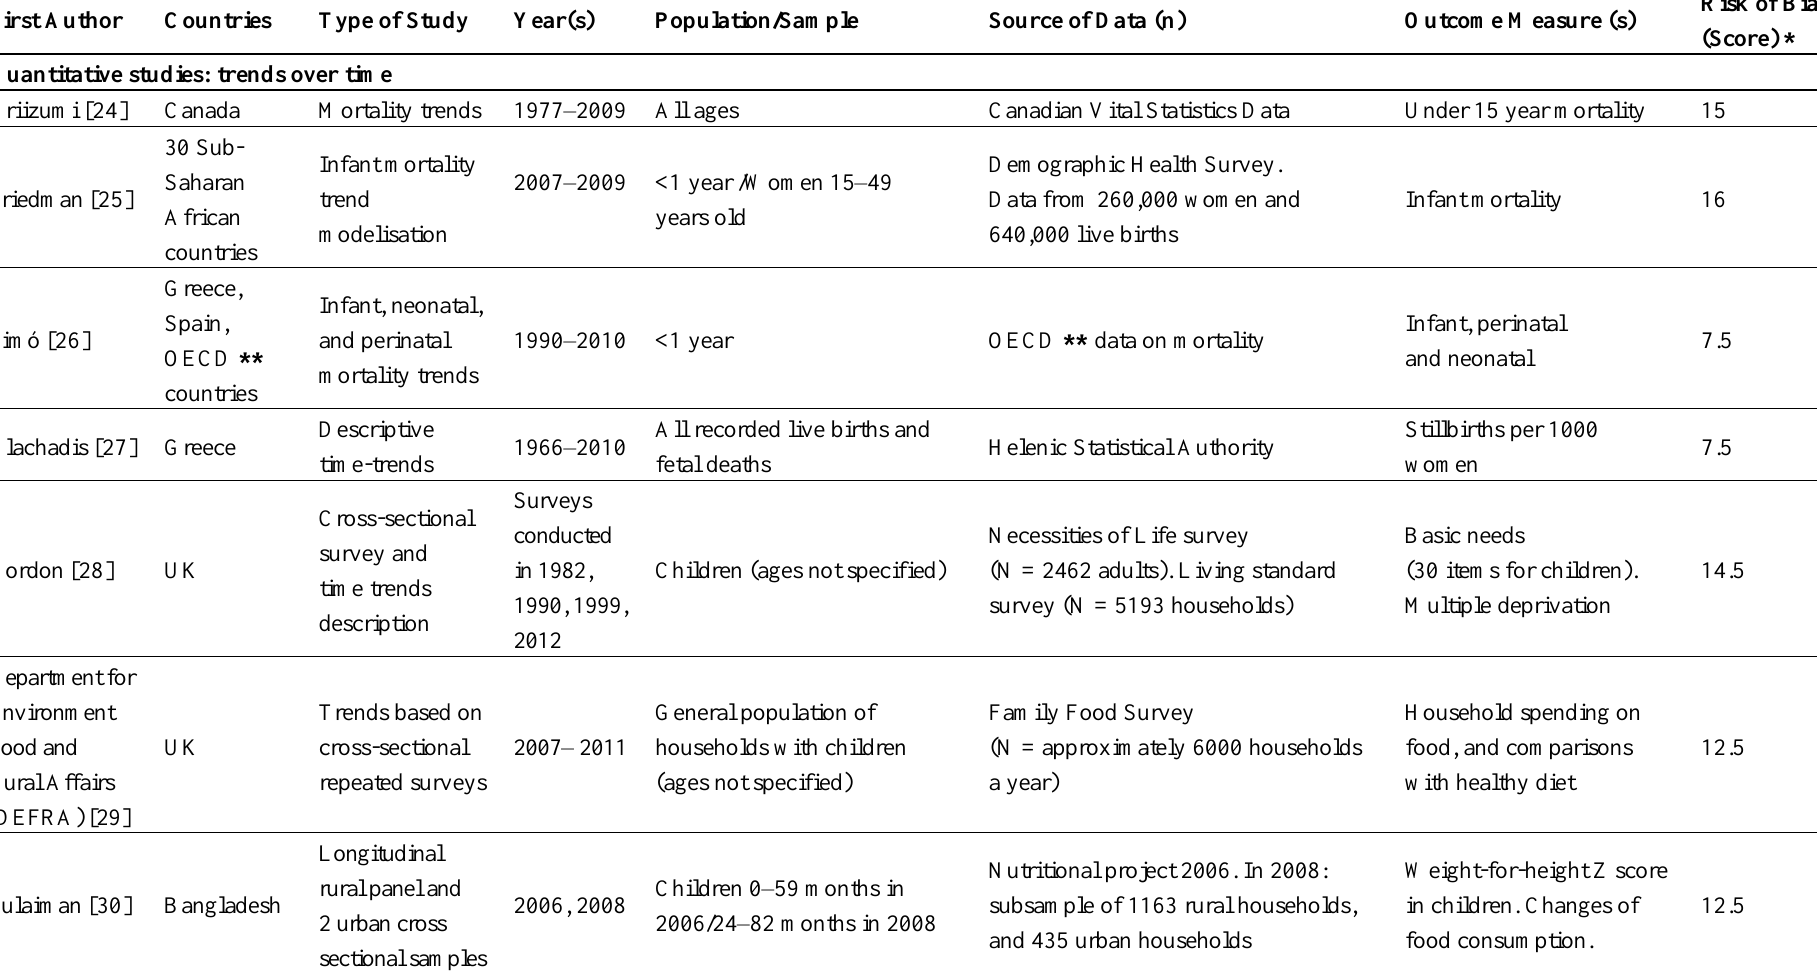
Table 1. Characteristics of included